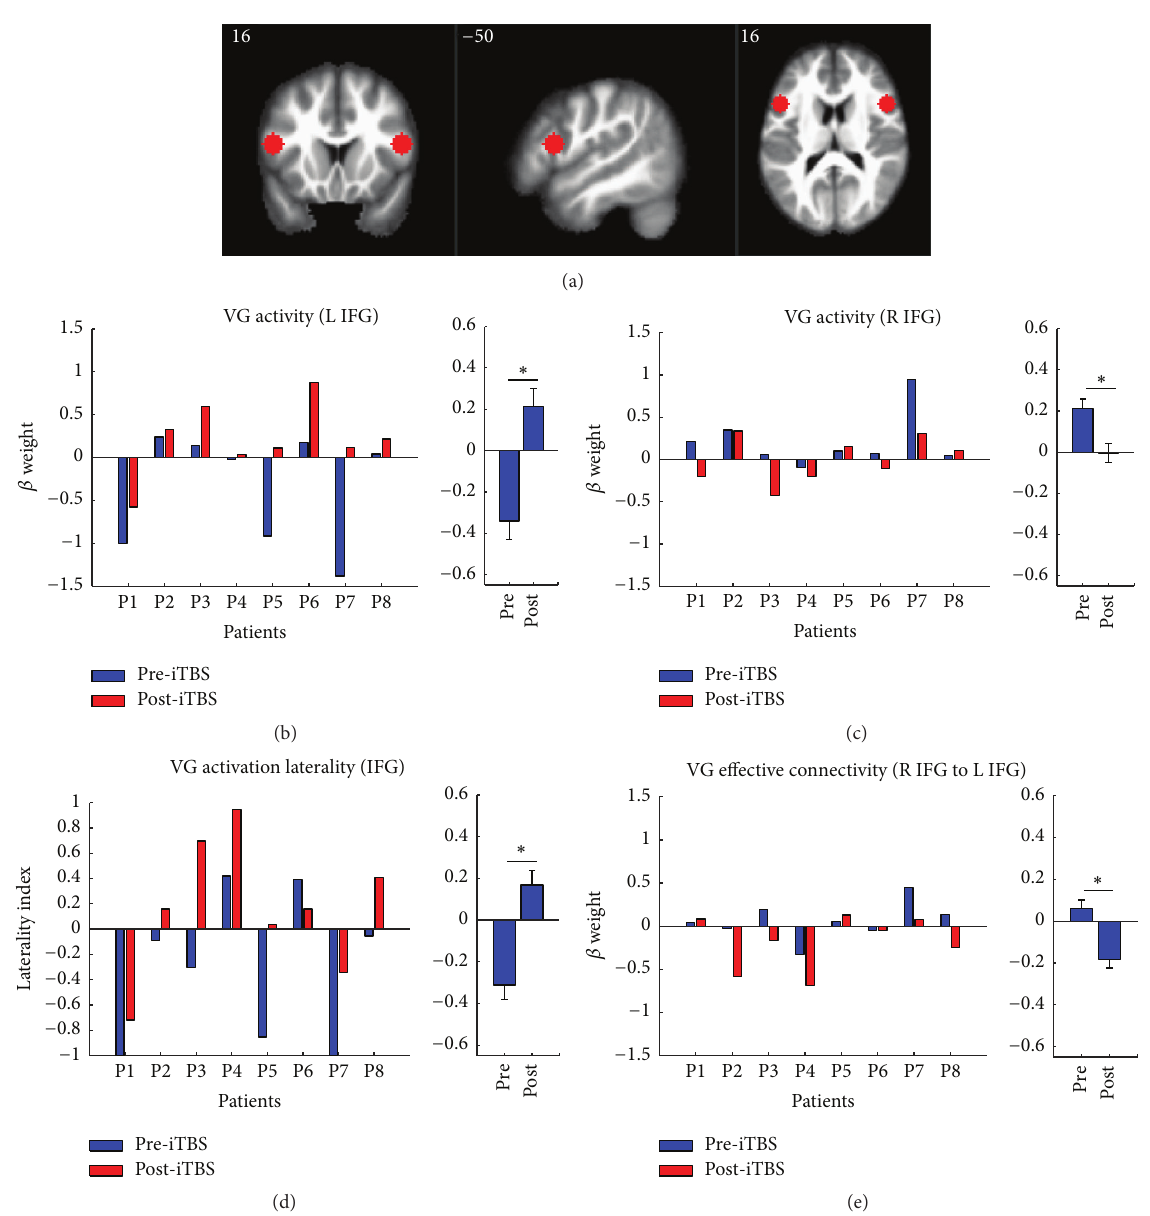
Figure 3: Results from ROI analyses. The left and right IFG ROIs are shown overlaid on slices from an anatomical template brain. The estimates of left (b) and right (c) IFG activation magnitudes, laterality indices (d), and effective connectivity from right to left IFG (e) are shown for the pre-iTBS (blue) and post-iTBS (red) sessions of each patient. For each plot in (b–e), bar graphs are shown on the right side that illustrate the mean and within-subjects standard error of the effect at pre-iTBS and post-iTBS sessions. ∗ Significant at FDR 𝑃 = 0.05